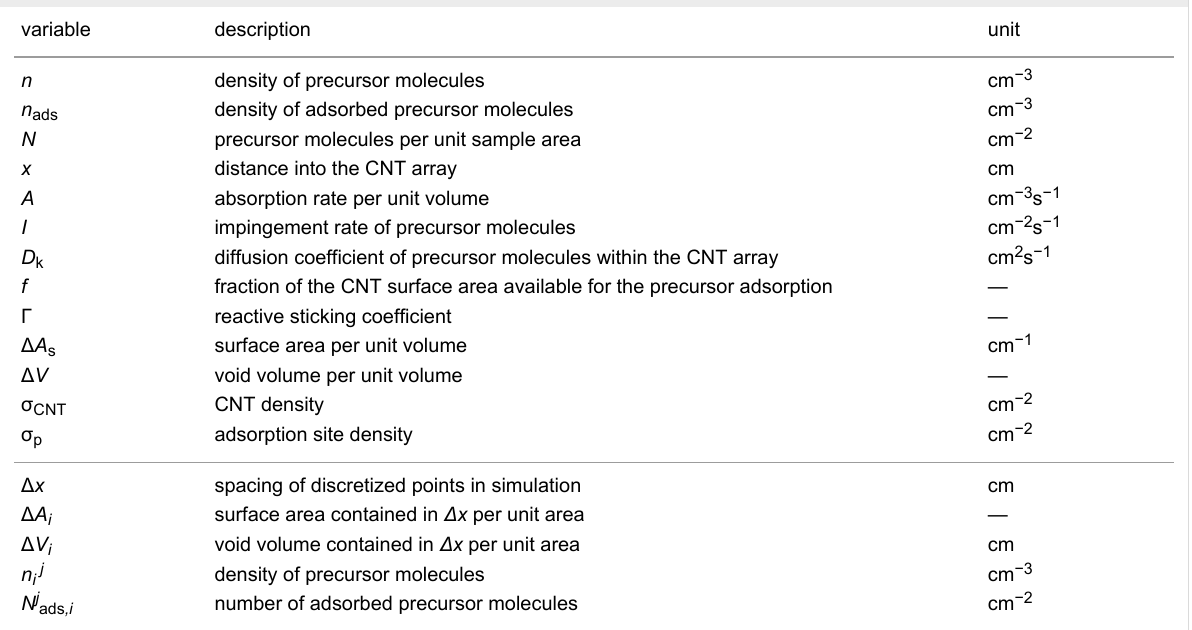
Table 2: Summary of important variables used in the modeling.